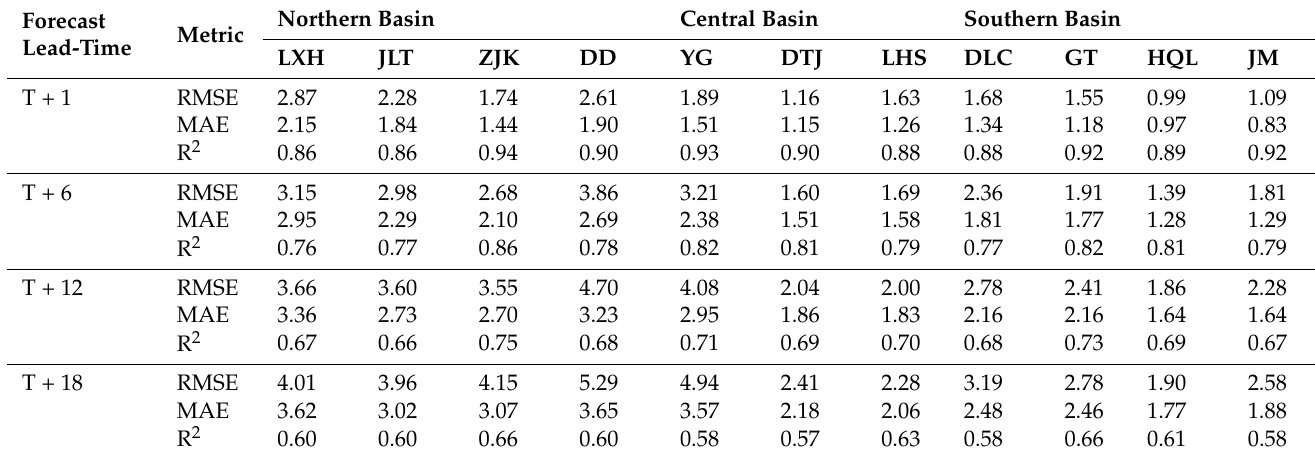
Table 2. Prediction performance of LSTM-attention model at each monitoring station.